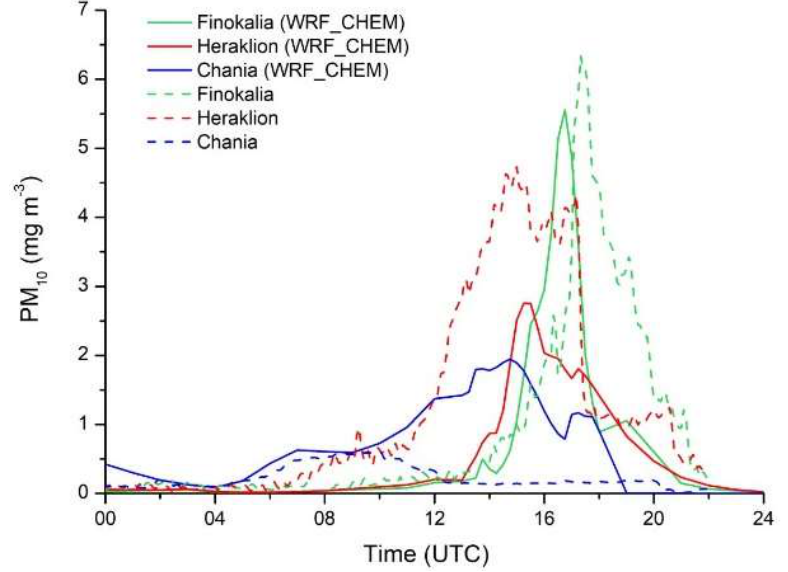
Figure 12. Timeseries of observed (dashed lines) and modeled (solid lines) PM 10 at Finokalia, Heraklion and Chania on 22 March 2018.